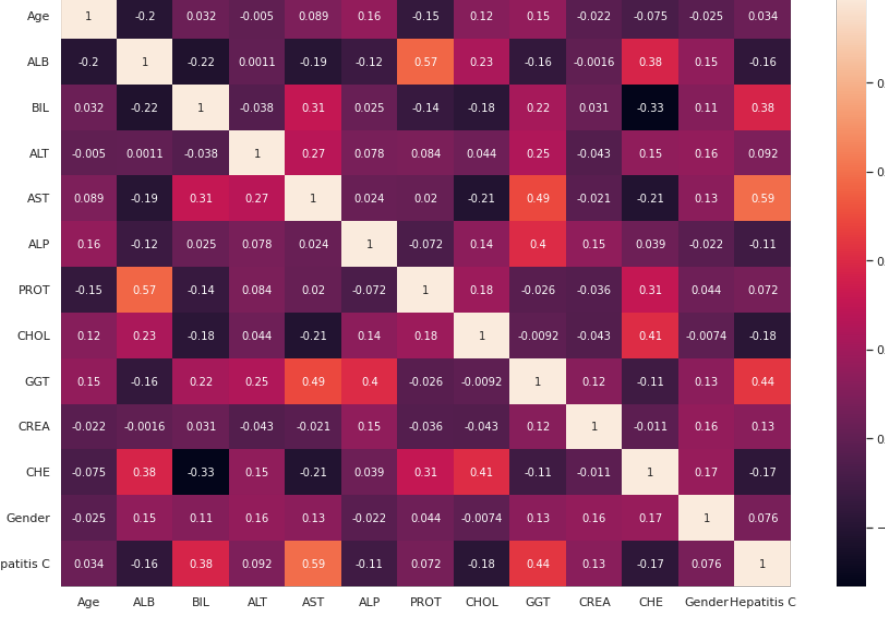
Figure 3. Heat map for the relation between different attributes based on the UCI dataset.